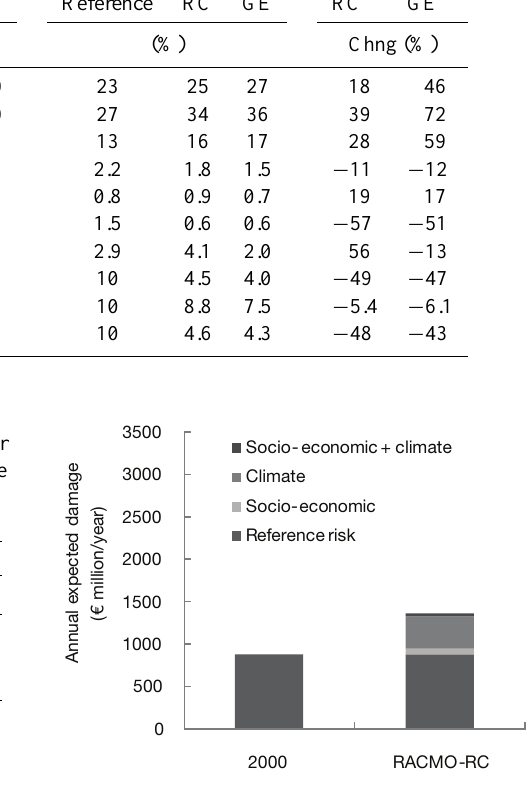
Table 5. Expected damage for different land use categories in 2000 and 2030 (at 2000 prices). Reference RC GE Reference RC GE